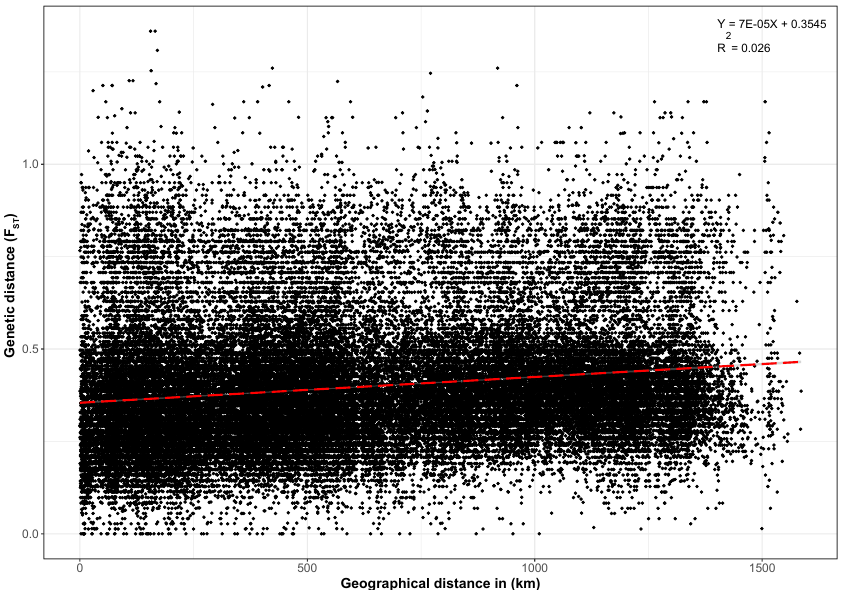
Figure 7. Correlation of the geographical distance (in kilometers) and genetic distance (pairwise F ST ) among the 365 rice